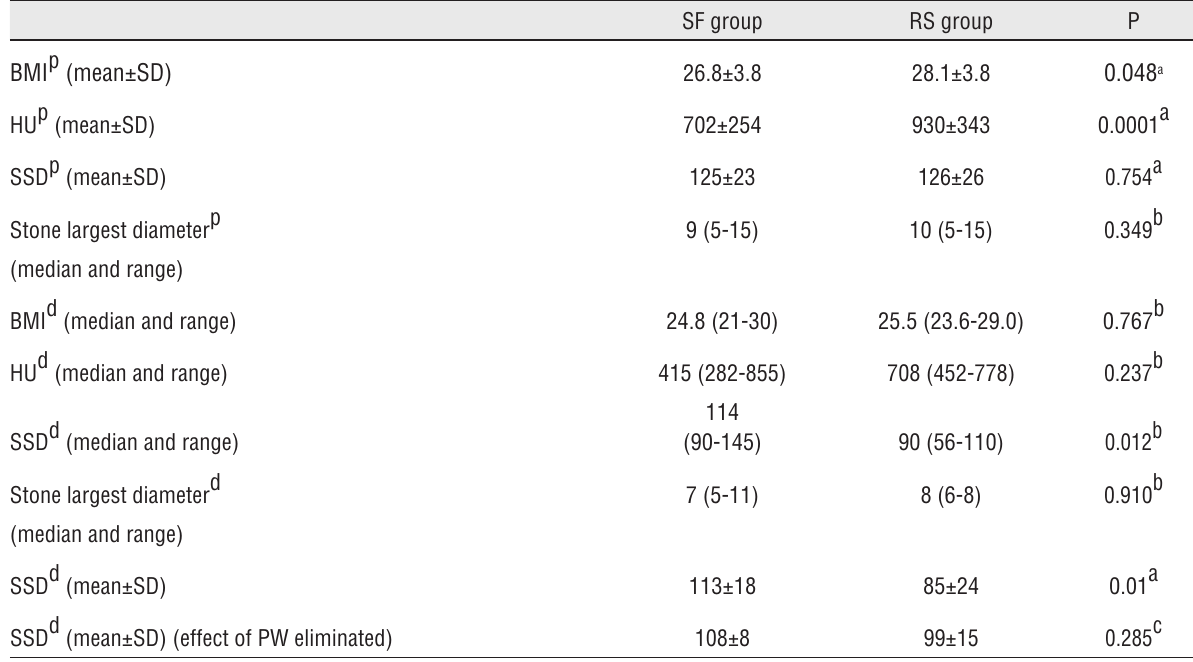
Table 2 - SWL outcomes for proximal and distal ureteral